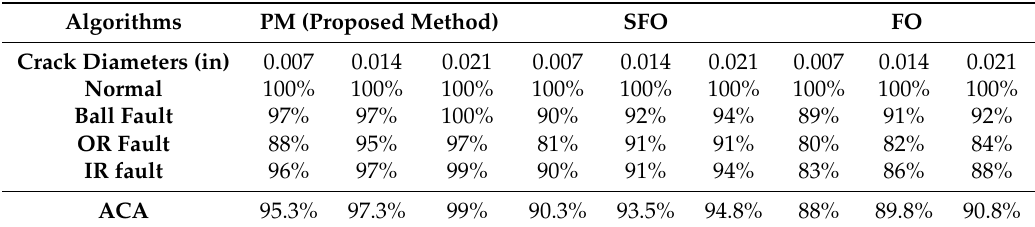
Table 3. The single fault diagnosis accuracy for 0 hp torque load.